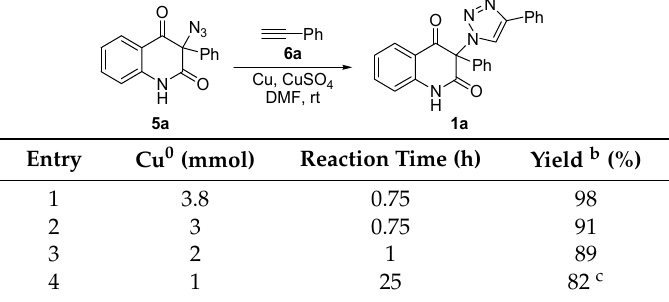
Table 1. The Effect of Granular Copper to the Conversion of 5a into 1a a .